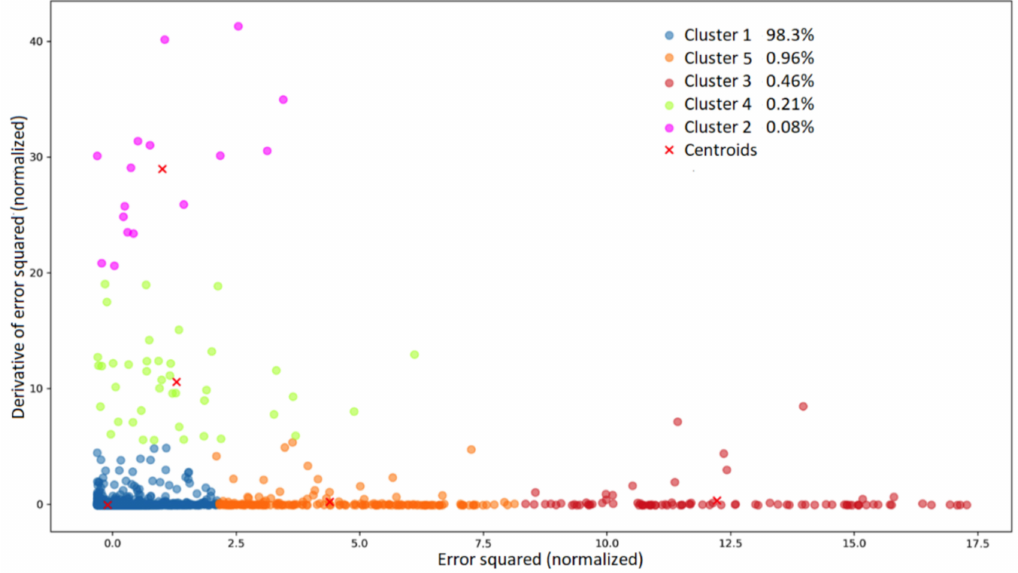
Figure 9. Cluster map for the physics-based linear-regression method K-means anomaly